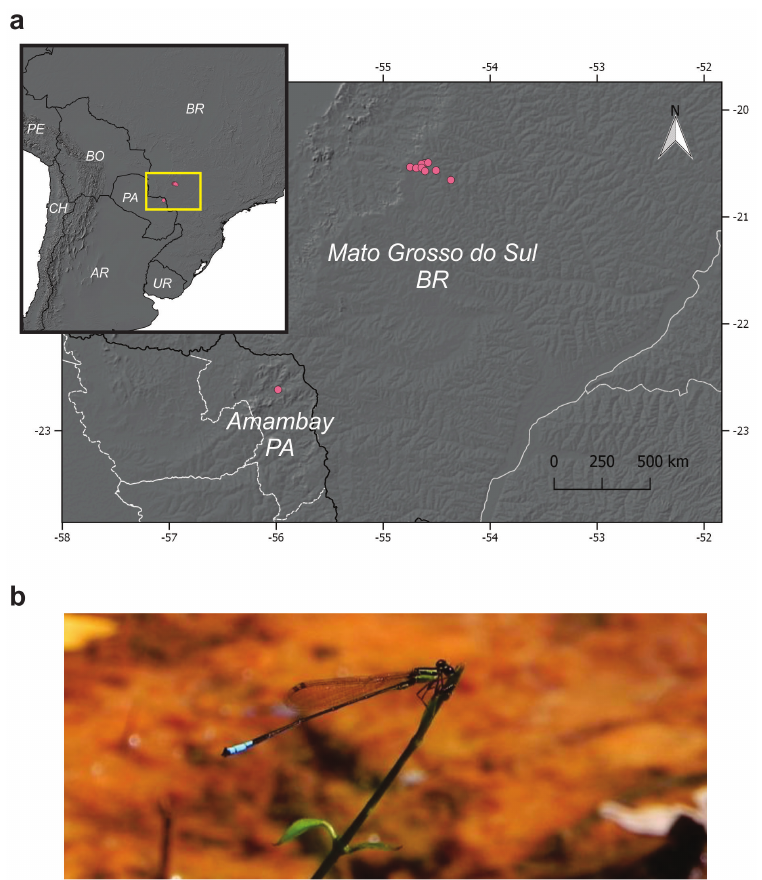
Figure 4 - a . Distribution map; b . Male perching on twig. Photo: Thiago Henrique